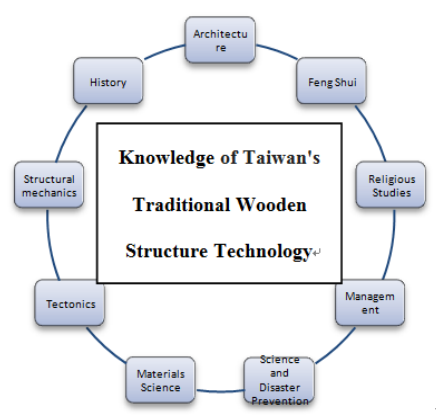
Figure 1 Science scope of traditional building carpentry